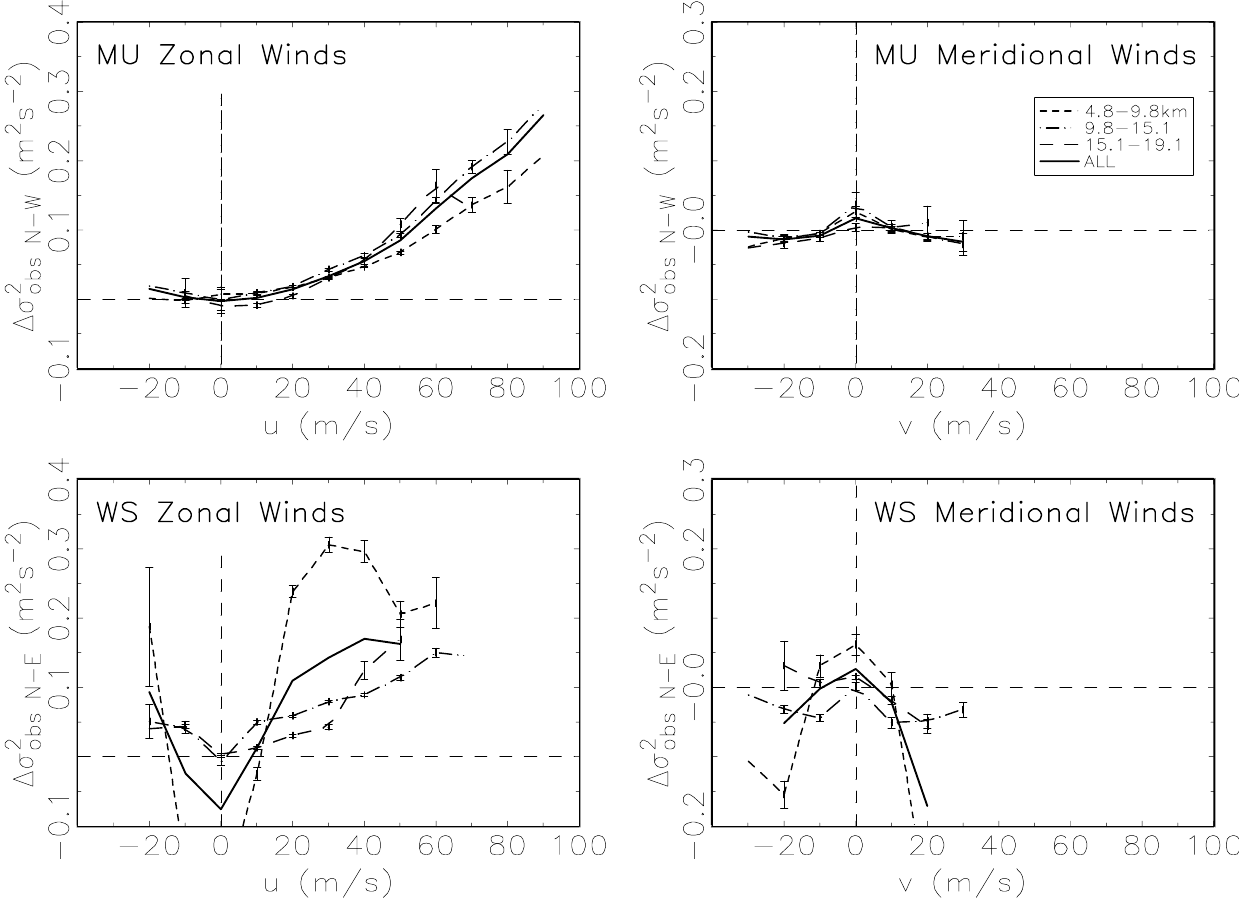
Fig. 2. Differences in σ 2 values between the meridional and zonal beams for the prevailing zonal (meridional) flow in the left (right) panels obs for MU (upper) and WS (lower). See